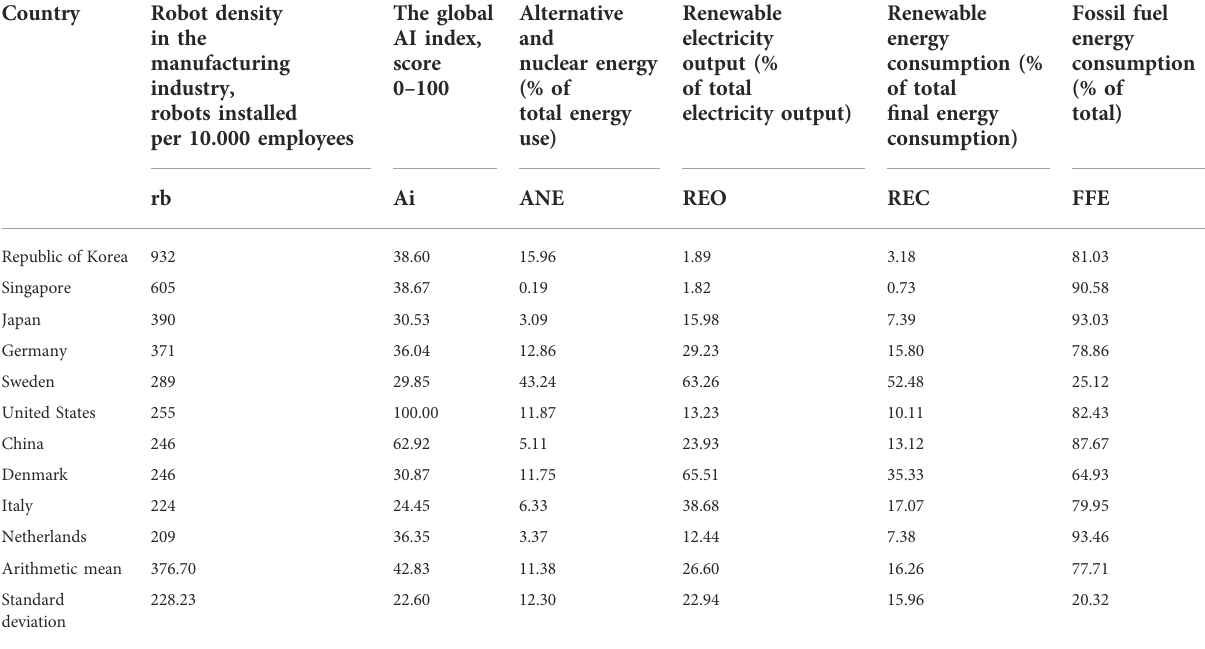
TABLE 1 The world experience in implementation of robots and AI and energy development. Country Robot density in